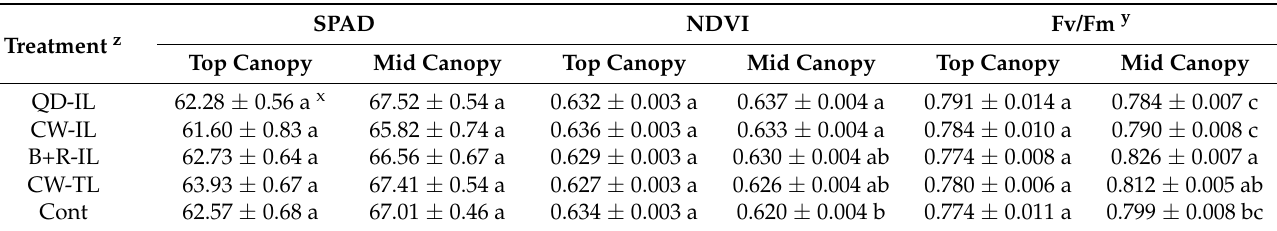
Table 2. Leaf characteristics of paprika after 56 days of supplemental lighting ± SEM (n = 21). SPAD NDVI Fv/Fm y Treatment z Top